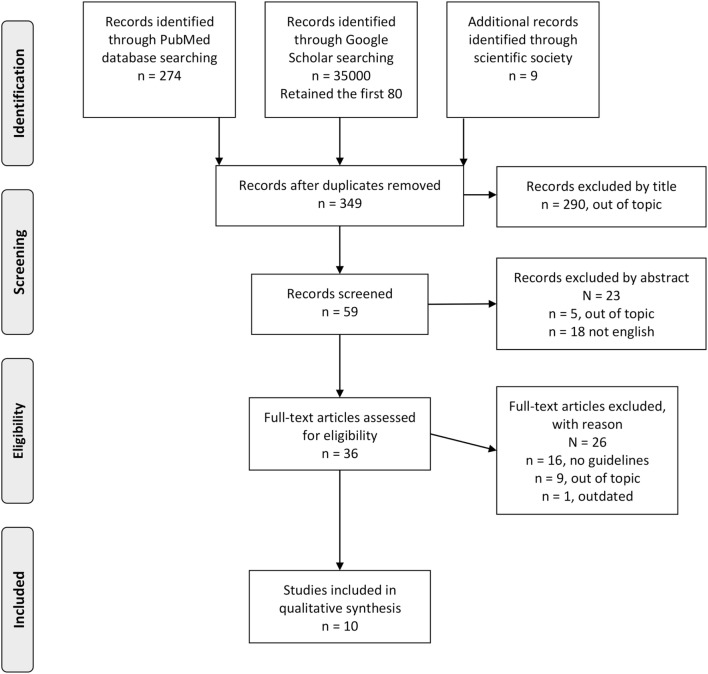
Flow diagram of the study selection process.